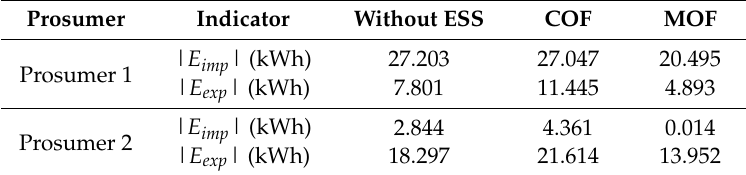
Table 2. Energy import and export for each of the prosumers with individual schedule. Prosumer Indicator